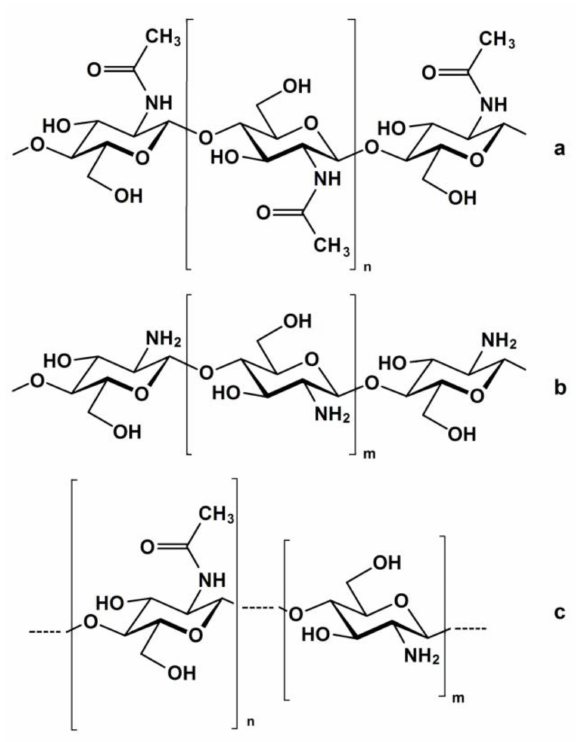
Figure 1. Chemical structure of ( a ) completely acetylated chitin [poly β -(1 → 4)-N-acetyl-D- glucosamine], ( b ) completely deacetylated chitosan [poly β -(1 → 4)-D-glucosamine], and ( c ) com- mercial chitin or chitosan, a copolymer characterized by its average degree of deacetylation (DD, %). Chitin and chitosan are distinguished by the content of amino groups (or deacetylated units). However, there are currently no generally accepted quantitative criteria. In some cases, this conditional boundary can be drawn according to the degree of deacetylation (DD), which is less than 50% for chitin and more than 50% for chitosan [11]. So, for chitin extracted from natural raw materials, DD ranges from 5 to 15%. Chitosan with DD ≥ 50% is soluble in an aqueous acidic environment [12,13]. The degree of deacetylation (DD, in molar percentage) is the ratio of the number of glucosamine units (acetylated units) to the total number of monomer units (acetylated, n, and deacetylated, m, units) in